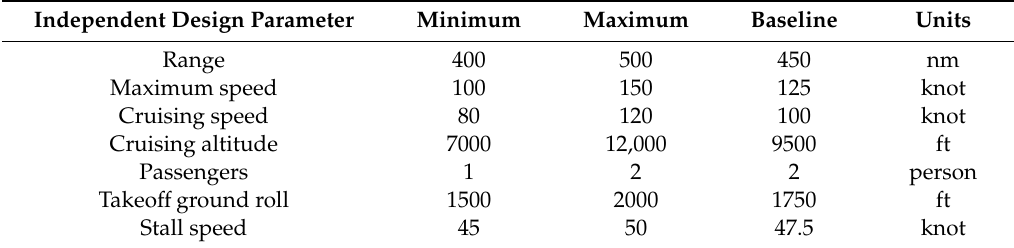
Table 2. Selected independent design